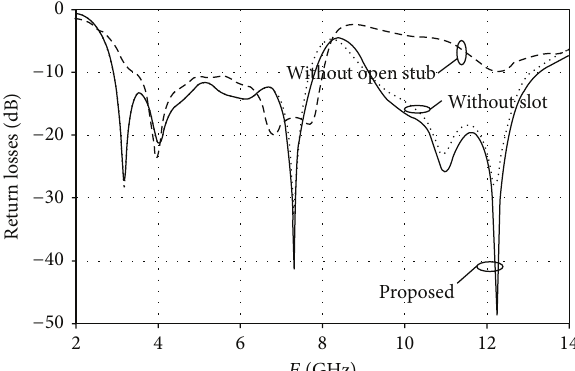
Figure 2: The proposed antenna without slot and without open stub.